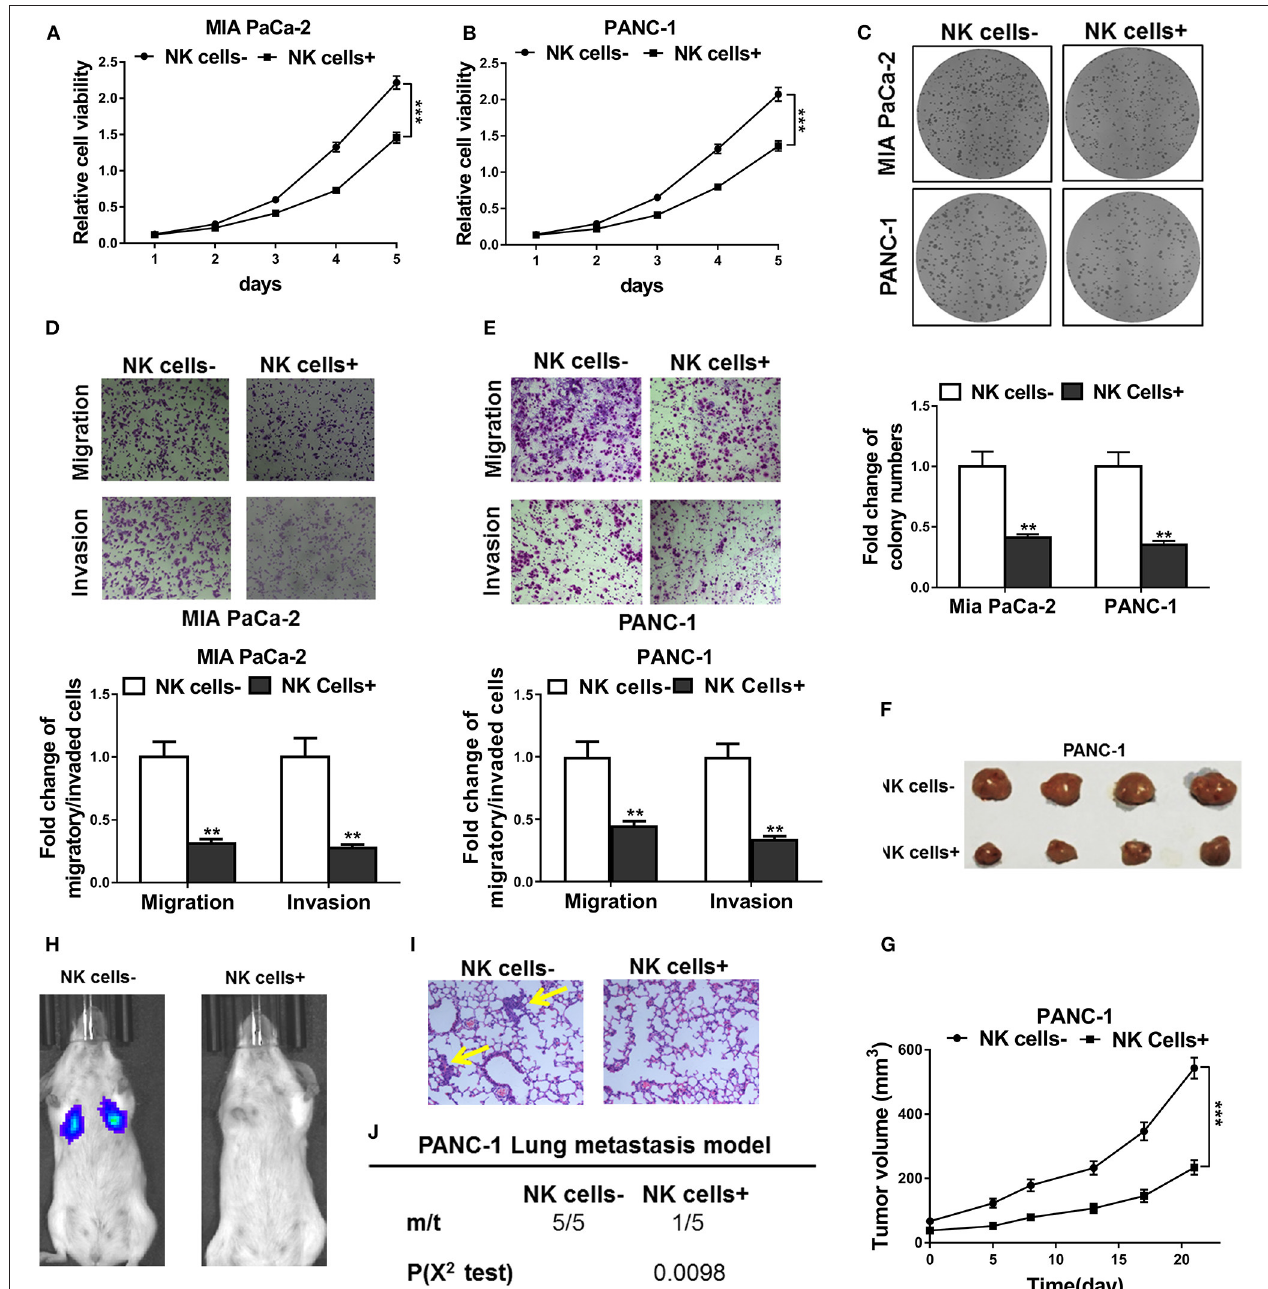
FIGURE 1 | NK cells co-culture inhibited tumor progression of pancreatic cancer both in vitro and in vivo . (A,B) CCK-8 assay showed cell viability of Mia PaCa-2 and PANC-1 cells co-cultured with (NK cells + ) or without (NK cells-) natural killer cells. (C) Colony formation assay showed cell proliferation of Mia PaCa-2 and PANC-1 cells co-cultured with (NK cells + ) or without (NK cells-) natural killer cells. (D,E) Transwell assays showed cell migratory and invasive ability of Mia PaCa-2 and PANC-1 cells co-cultured with (NK cells + ) or without (NK cells-) natural killer cells. (F,G) PANC-1 cells were implanted into the flank of mice ( n = 4 each group), without (NK cell − ) or with co-injection of natural killer cells (NK cell + ), respectively, followed by growth curve evaluation on the indicated day after injection. (H–J) Representative in vivo images showed tumor colonization in the lungs of mice ( n = 5 each group) following tail vein injection of PANC-1 cells, without (NK cell − ) or with co-injection of natural killer cells (NK cell + ), respectively, H&E staining of lung sections of mice (metastatic nodules were indicated by yellow arrow, 200 × ) and incidence of lung metastasis in mice following tail vein injection of the respective PANC-1 cells. The data represent the mean ± SD from three independent experiments. ** P < 0.01; *** P < 0.001, two-way ANOVA for (A,B,G) , χ 2 test for j, Student’s t -test for